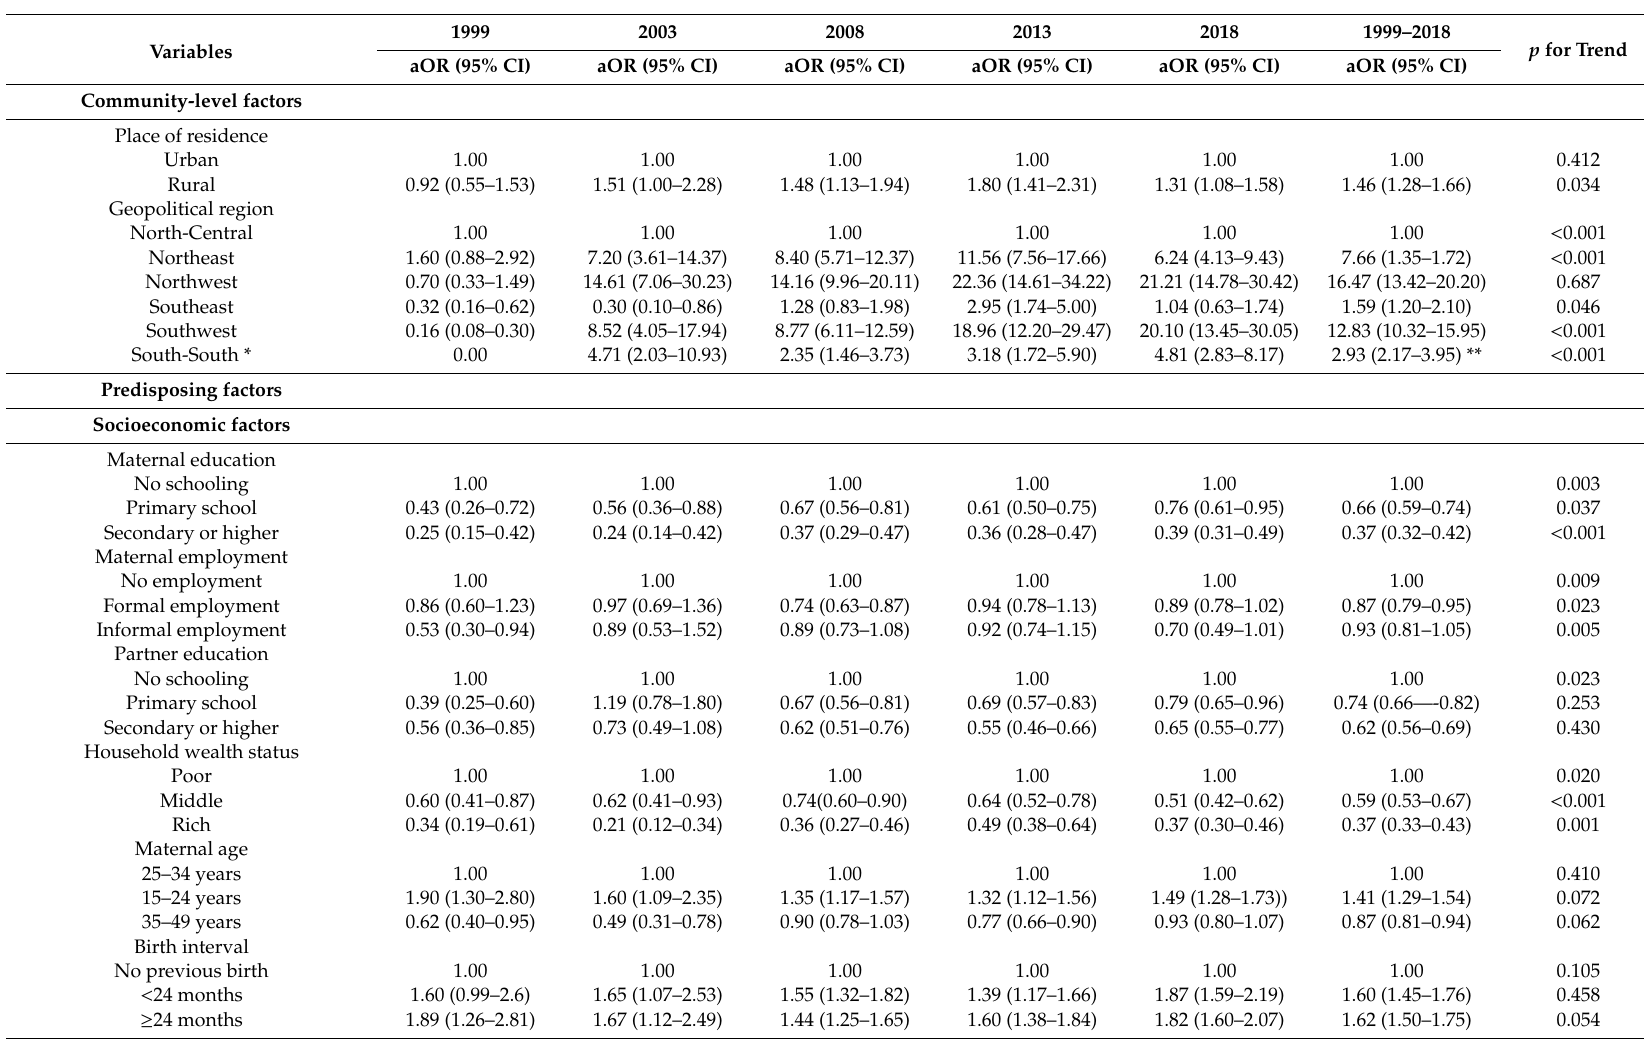
Table 3. Determinants of traditional-birth-attendant-assisted delivery in Nigeria,